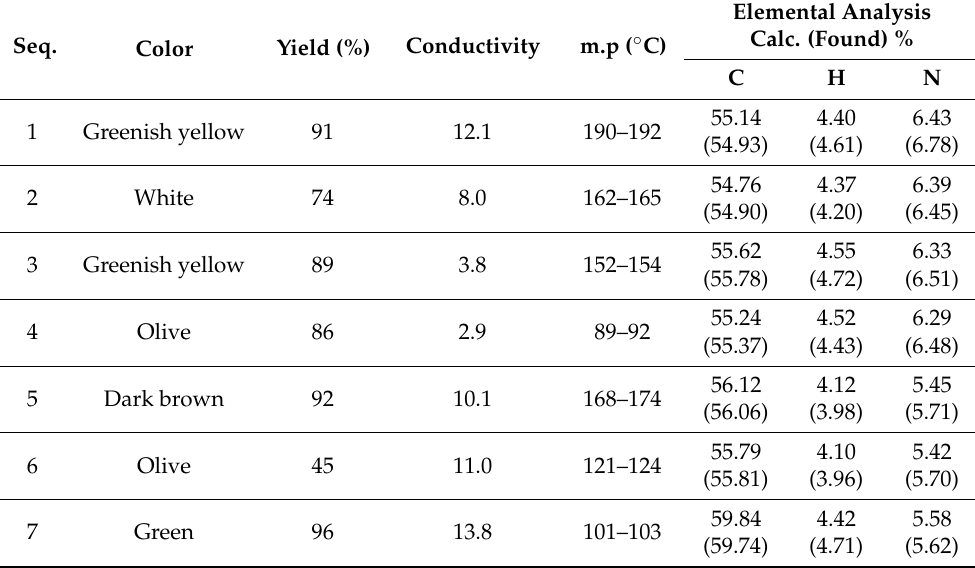
Table 1. Physical properties and elemental analysis.